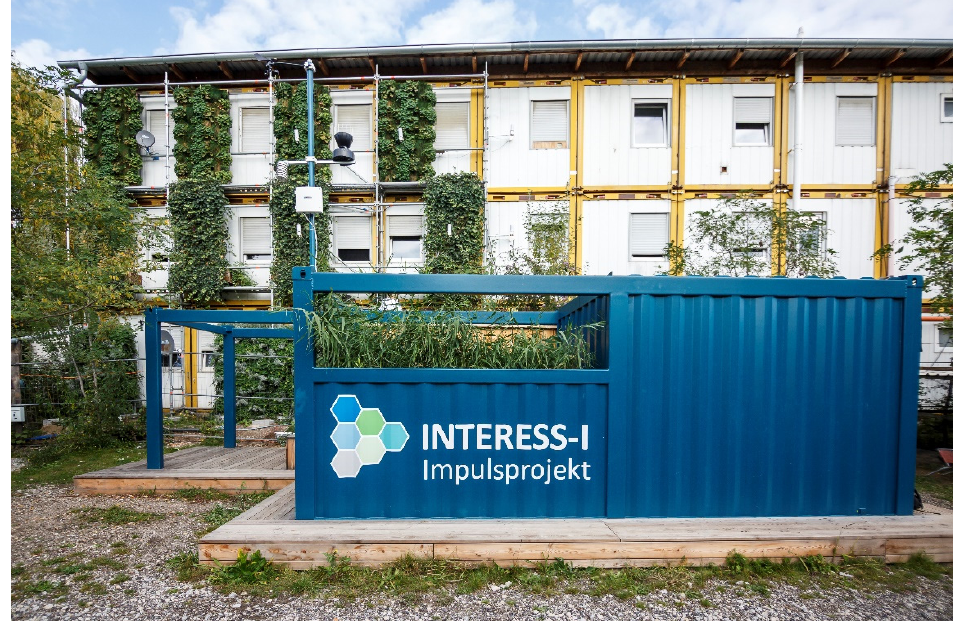
Figure 1. Front view perspective of the modular container-based vertical-flow constructed wetland (VFCW) to treat light greywater from showers and handwash basins for use as irrigation water for the building facade (Photo: J. Rettig).